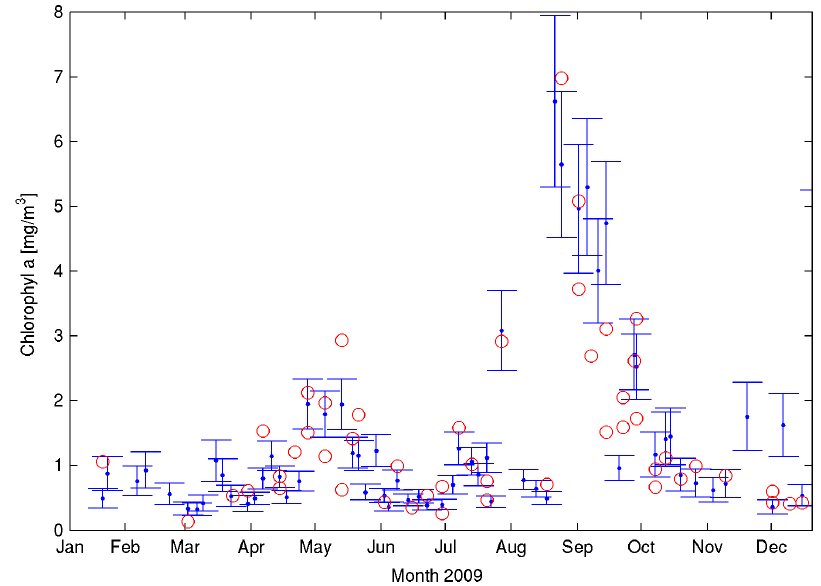
Figure 1. Surface chl at L4 during 2009 as observed from satellite (blue with assigned error bars) and in situ HPLC analysis